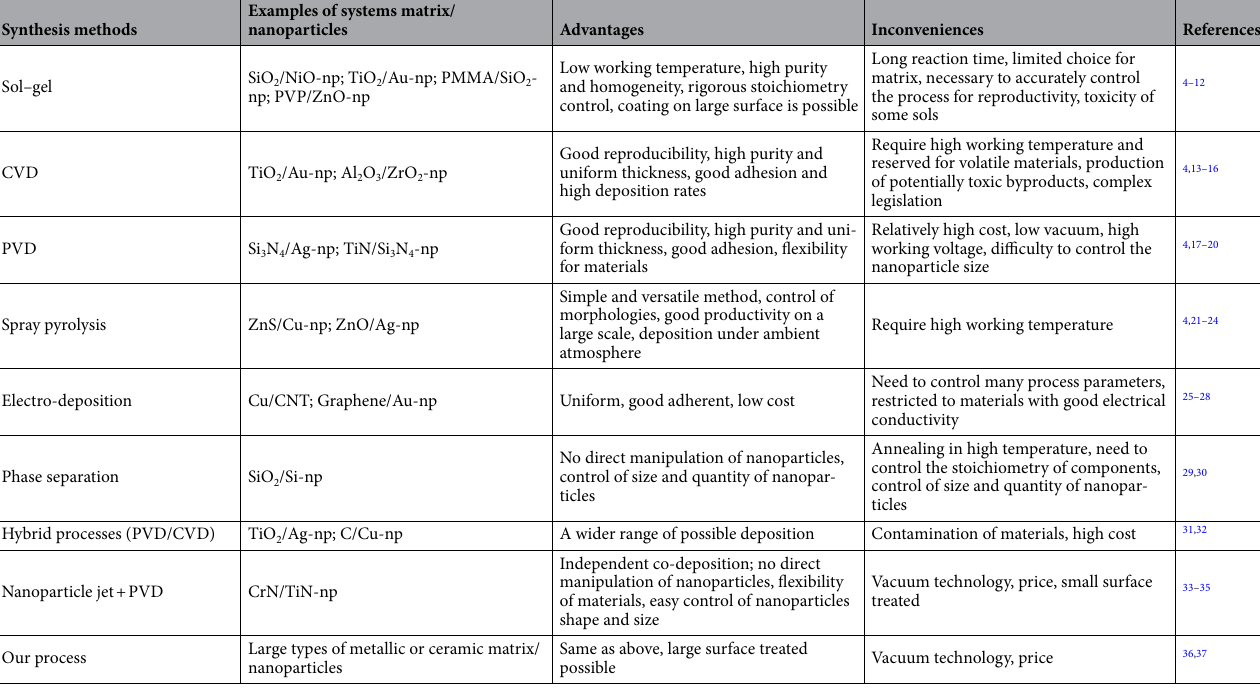
Table 1. Comparison of different technologies of nanocomposite thin film